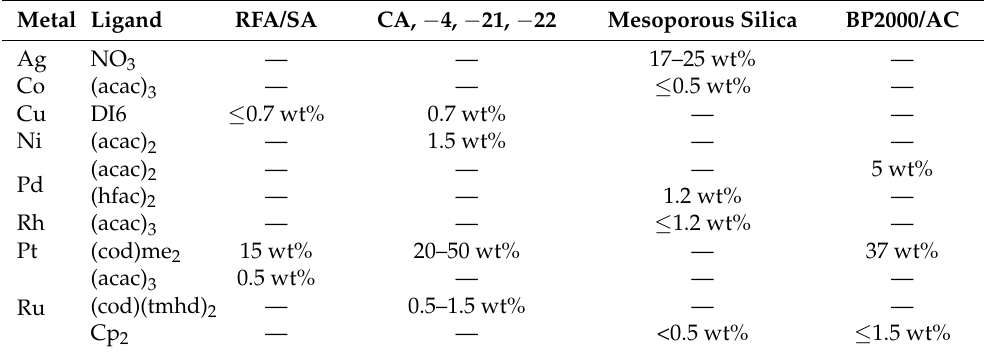
Figure 15. Pd and Pt loading on BP2000 and Co loading on MCM-41 at 20 MPa and 333 K; data taken from [8,60]. For reasons of clarity, only the linear regressions are depicted. Table 12. Metal loadings on different substrates obtained from the adsorption experiments listed in Table